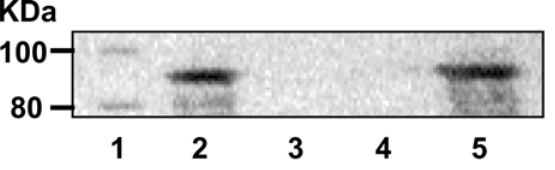
Figure 3. Western blotting using a -PA antibody. Strains grown in R Media with 0.8% NaHCO 3 under 5% CO 2 at 37 u C supplemented with Erythromycin and Lincomycin as appropriate. Amount of sample loaded on 10% SDS-PAGE gel was normalized relative to cell density. Lane 1, MagicMark XP; Lane 2, 34F2 strain; Lane 3, 34F2 D BAS2714-12 strain; Lane 4, 34F2 D BAS2714-12 strain carrying plasmid pHT315; Lane 5, 34F2 D BAS2714-12 strain carrying plasmid pAW144.